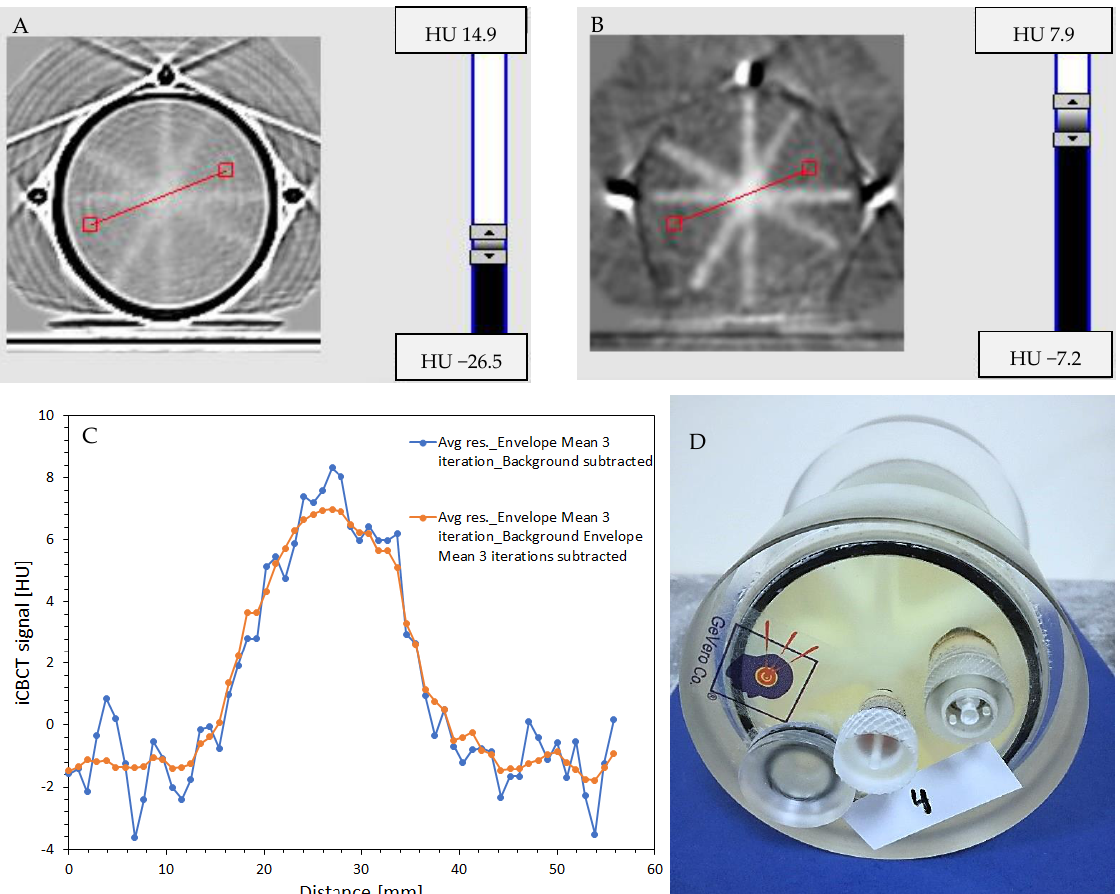
Figure 7. Processing of iCBCT images of PABIG nx in PH-5-DD1 GeVero Co. container irradiated with TrueBeam accelerator (mode: Pelvis): ( A ) is for the mean series (calculated from three series) filtered with the Envelope filter (mean, 3 iterations, Kernel = 3, Kernel mode = 2D, Kernel unit = pixels), with background subtracted (non-irradiated dosimeter), and ( B ) is like ( A ). However, the background was also filtered with the Envelope filter (same parameters). ( C ) is for profiles along the red lines in ( A , B ). ( D ) is for a photograph of PABIG nx ; the white regions inside the container are the effect of the polymerization and crosslinking of PABIG nx monomers and correspond to the photon beams passing through the dosimeter according to the star-shot isocenter pattern of